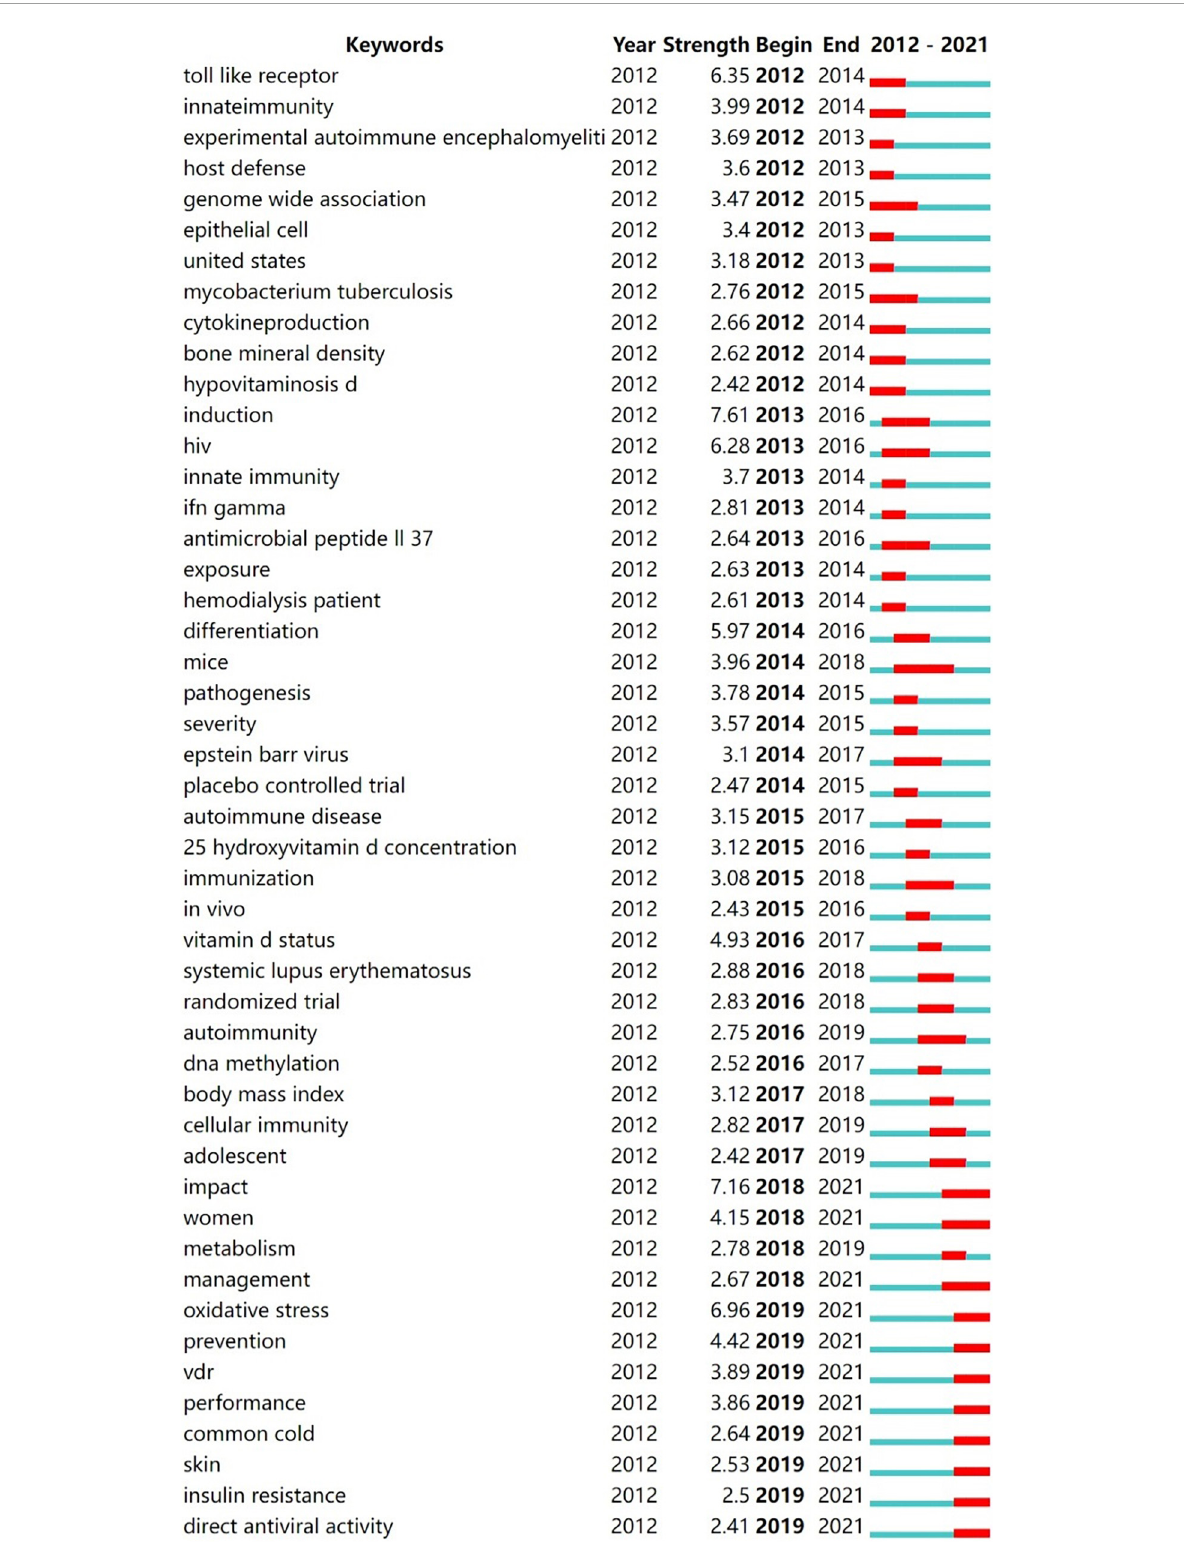
FIGURE7 Keywords with the strongest citation burst (2012–2021). The red line shows the duration of the keyword citation burst, indicating the progress of the frontier hot topics.